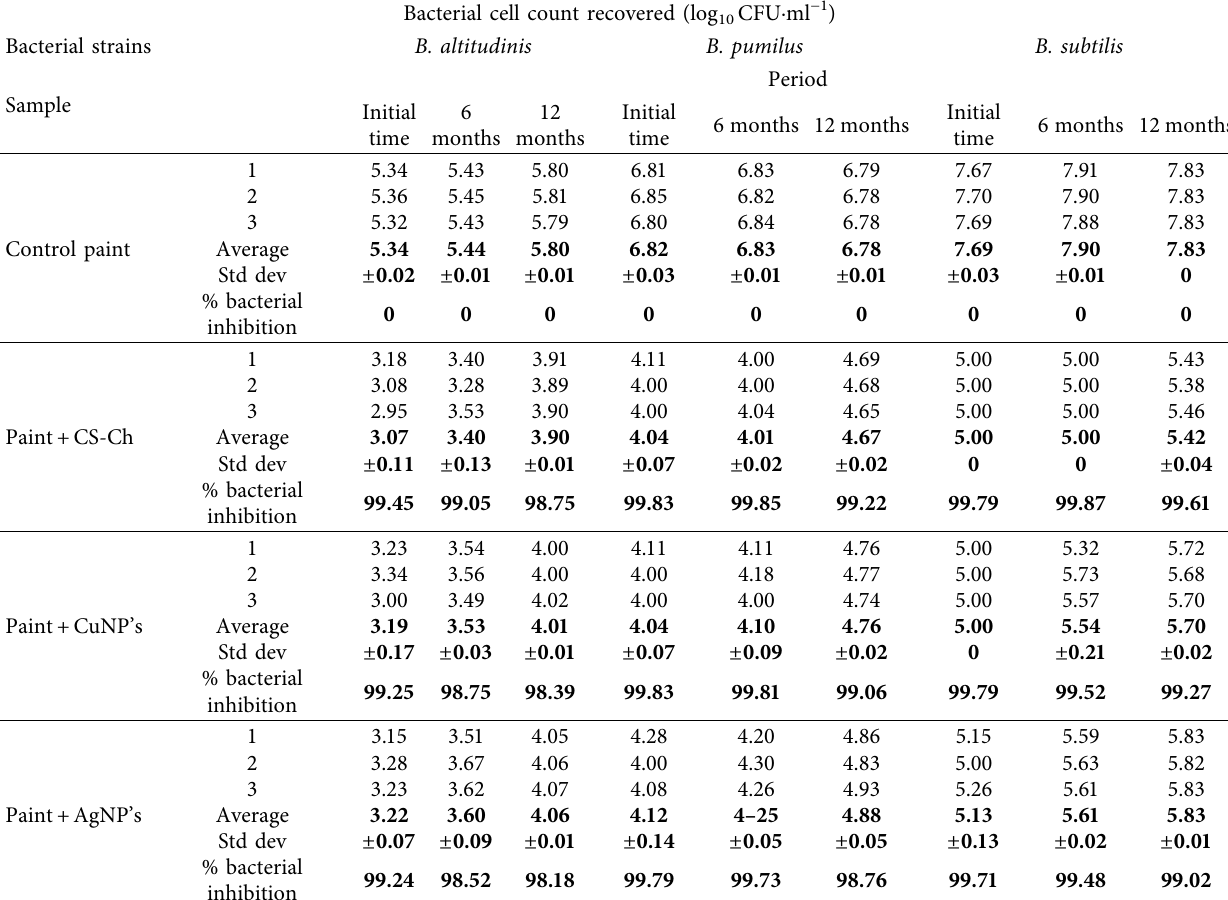
Table 4: Bacterial cell count recovered from JIS Z2801-ISO 22196 (log